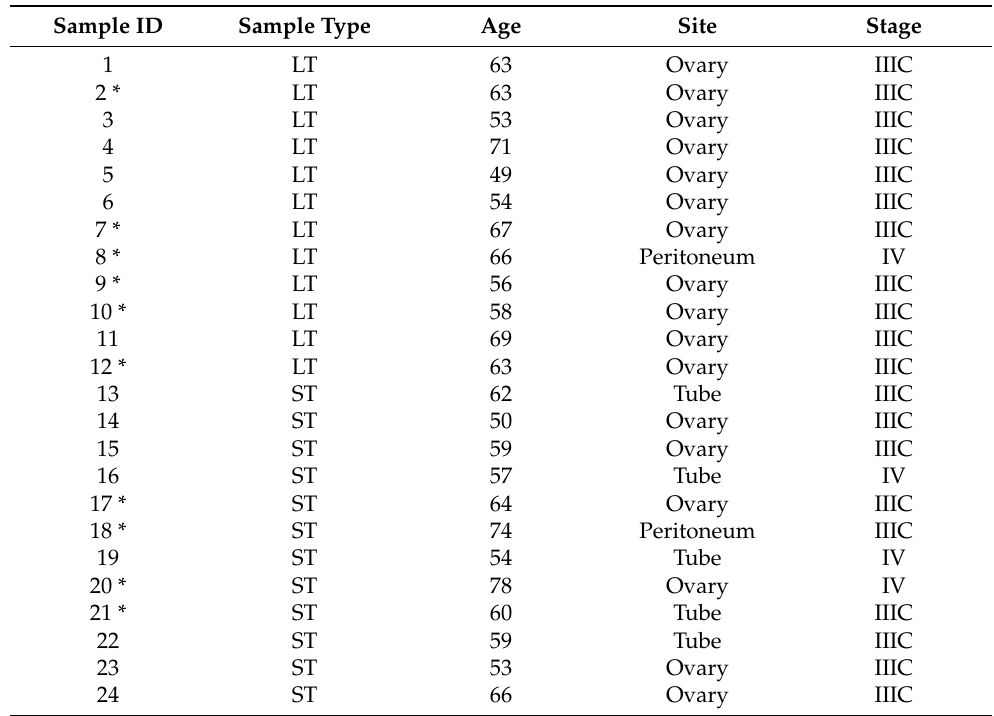
Table 1. Characterization of patients with ovarian cancer who had LTS or STS. * Samples used for whole-genome